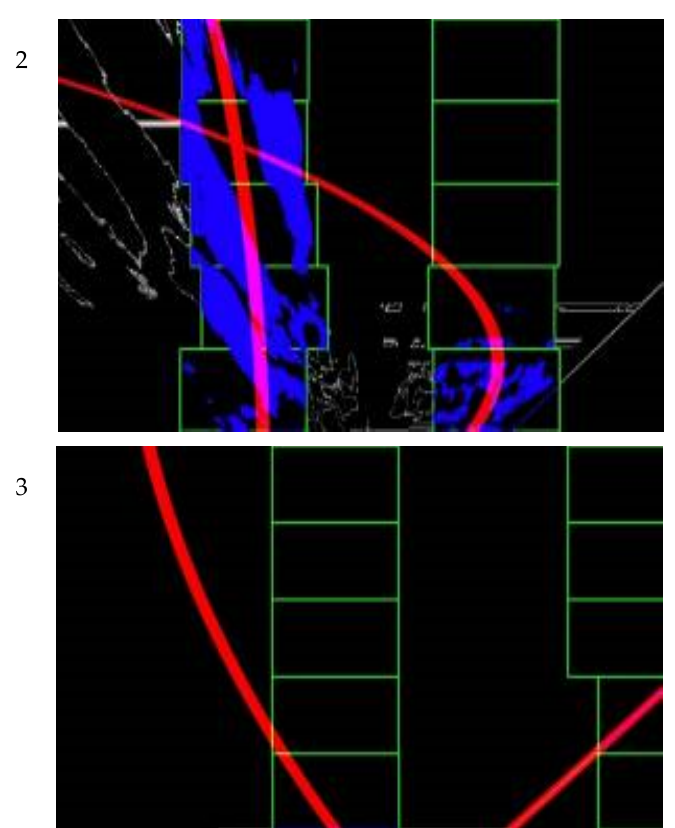
Figure 7. Sliding window comparison with the polynomial fit using Manhattan distance. The upper image ( 1 ) was successful detection; center image detection ( 2 ) was moderate detection; and the lower image ( 3 ) indicated no row detection.